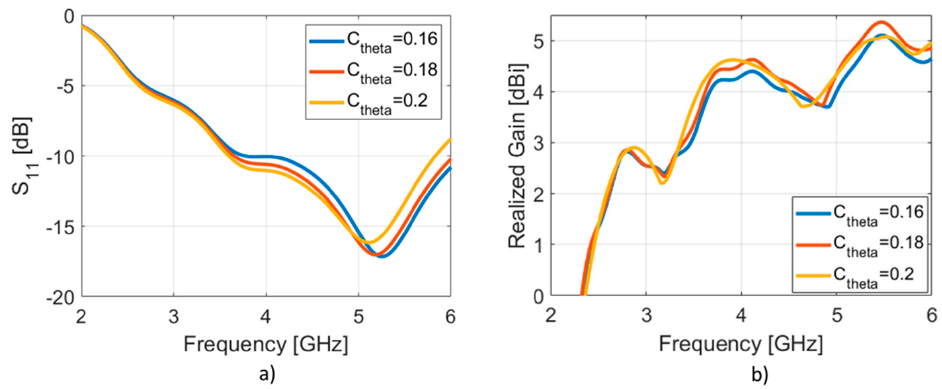
Figure 6. ( a ) Scattering Parameter S 11 and ( b ) gain of the optimized SsDRA as the coefficient c theta is varied: 0.16, 0.18 and 0.20.